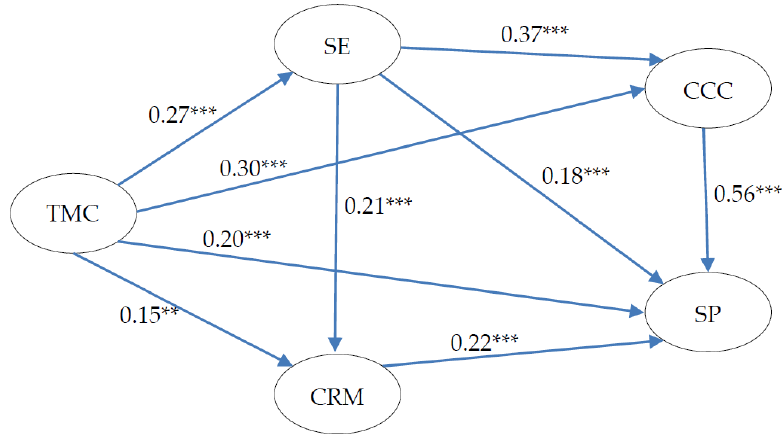
Figure 3. Testing results of the research model. ** p < 0.01, *** p < 0.001.